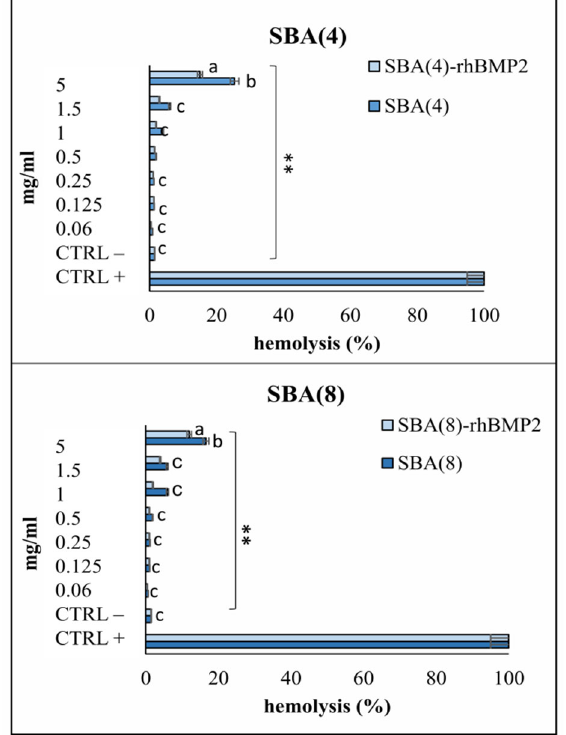
Figure 6. Hemolytic activity of unloaded and rh-BMP2-loaded MSNs after 60 min of incubation at 37 ◦ C). ** indicates statistically significant difference ( p < 0.001) between treated cells and untreated (controls), while different letters suggest statistically significant differences ( p < 0.001) among concentrations.